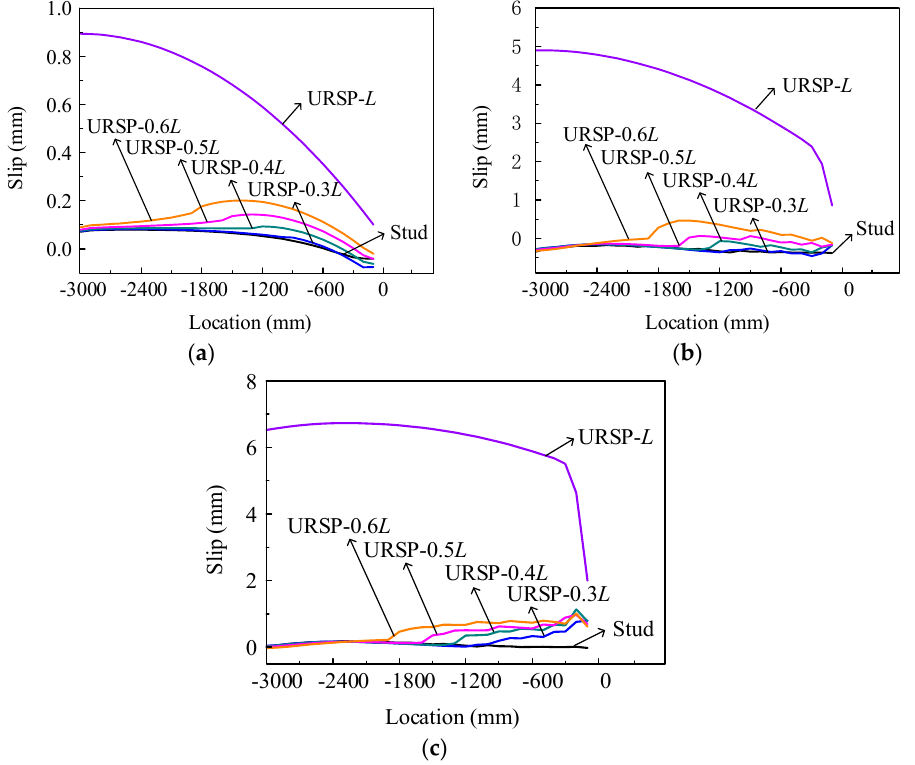
Figure 12. Interface slip distribution under the hogging moment. ( a ) u =10 mm; ( b ) u =70 mm; ( c ) u =150 mm.